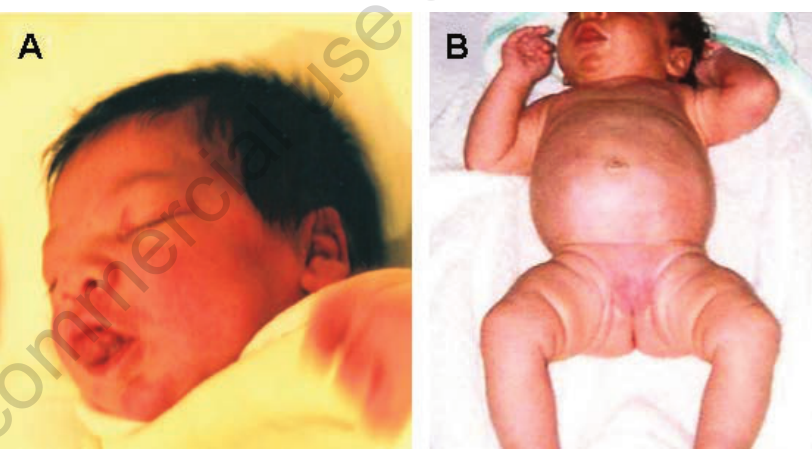
Figure 2. Coarse facies (A) and prominent abdomen (B) in a 2-month old infant affected by mucopolysaccharidosis type I Hurler.